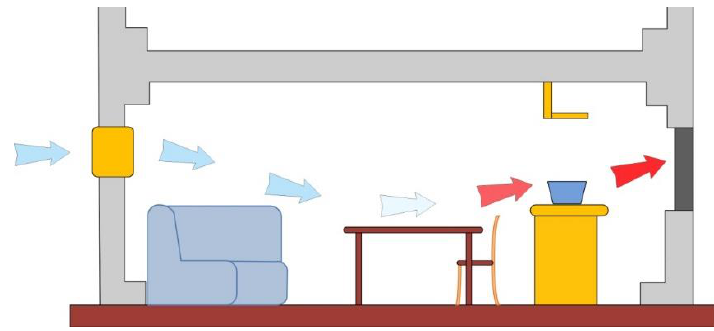
Figure 3. Conceptual design of the proposed window-type convection device.